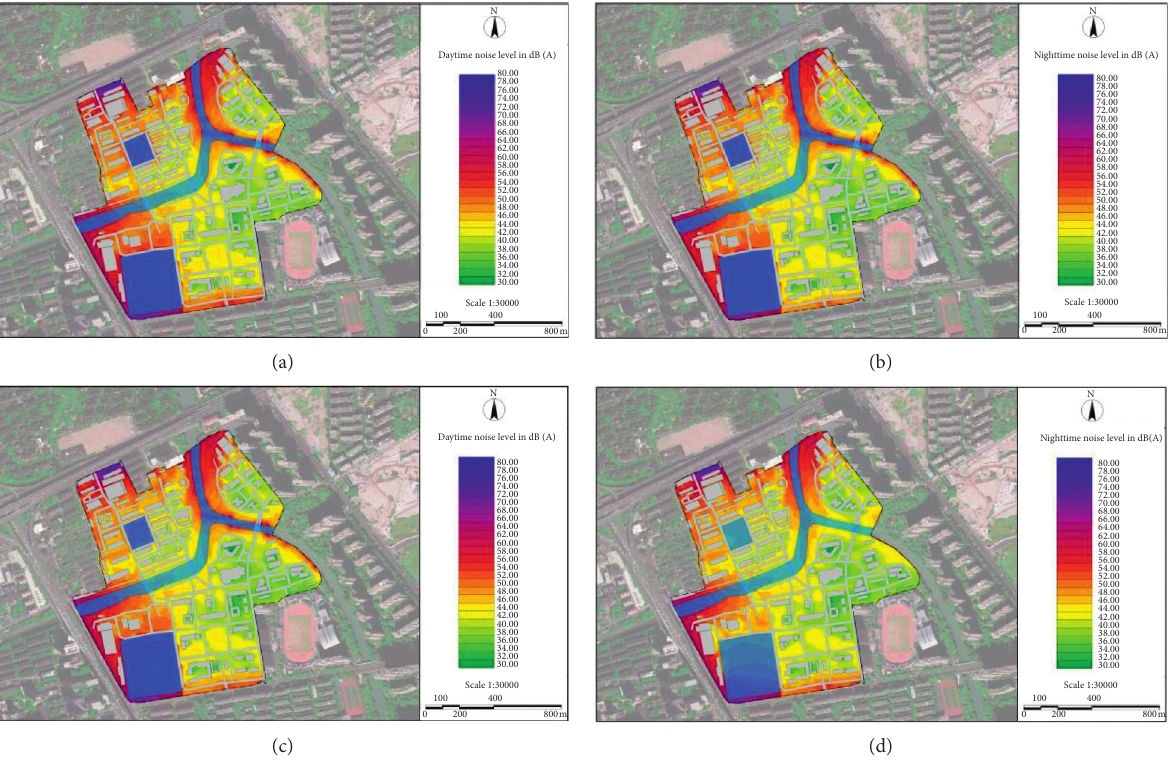
Figure 12: Simulation results of the campus of Zhejiang University of Technology with combination optimisation of greenbelts and noise barriers: (a) weekdays daytime, (b) weekdays nighttime, (c) weekends daytime, and (d) weekends